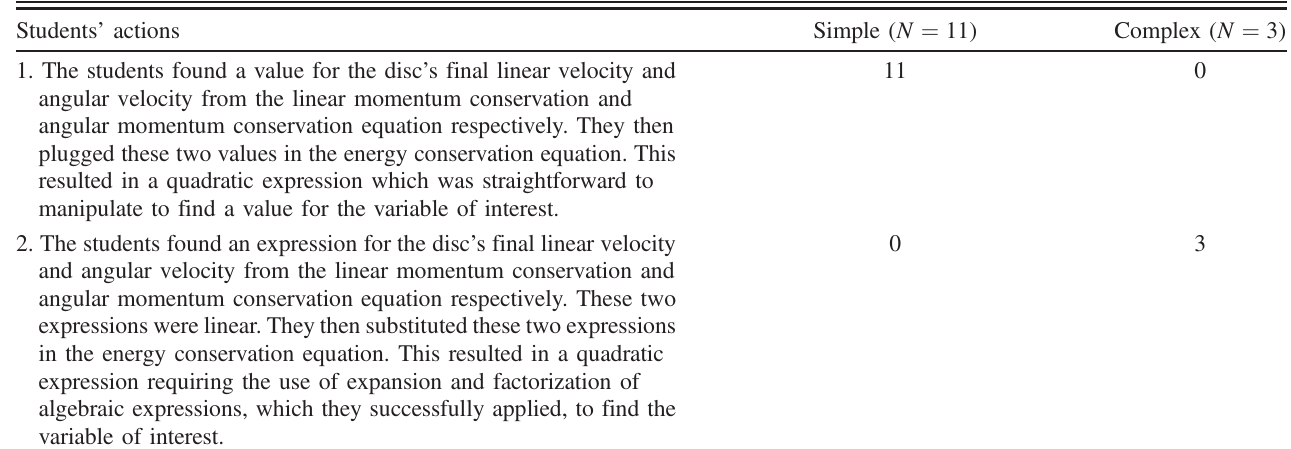
TABLE V. Actions of those students who combined and simplified the equations formulated for the simple and complex simultaneous synthesis tasks.